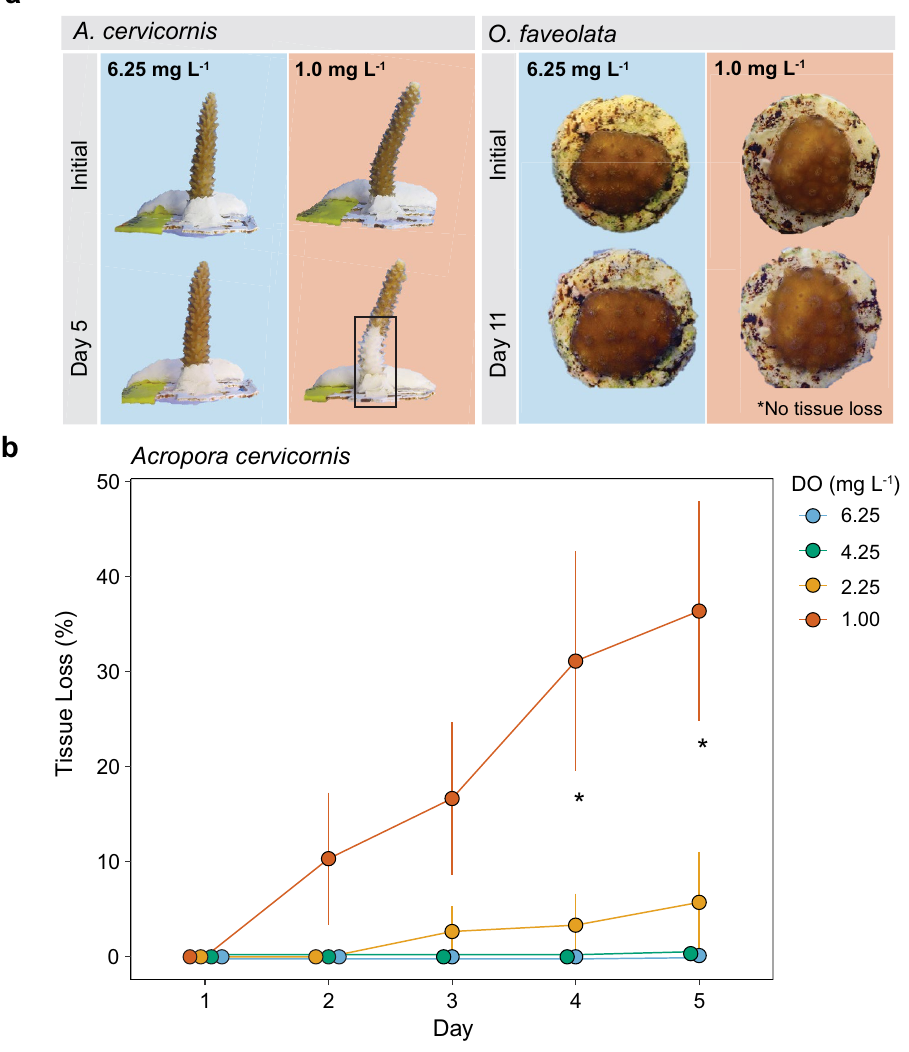
Figure 2. Tissue loss under deoxygenation. ( a ) Representative photos of coral fragments in the 6.25 and 1.00 mg L −1 dissolved oxygen (DO) treatments at the start and end of experiments. Fragments were monitored for visual signs of coral bleaching or tissue loss (black box) daily. ( b ) Mean ± SE percent tissue loss of A. cervicornis fragments over the duration of the study (n = 3). Day 1 represents measurements made on the first day of the experiment. Asterisks indicate significant differences ( P < 0.05) between the 1.00 mg L −1 treatment and all other treatments on a given day.